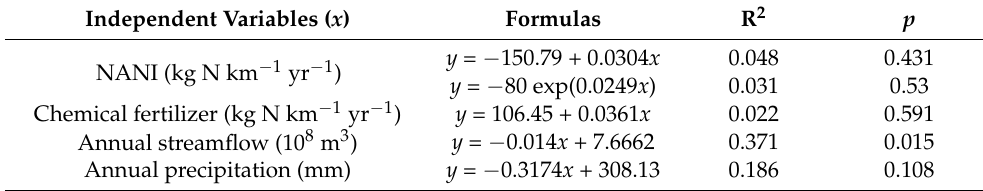
Figure 7. Temporal variations in the riverine N export and NANI in the UNW from 2005 to 2019.